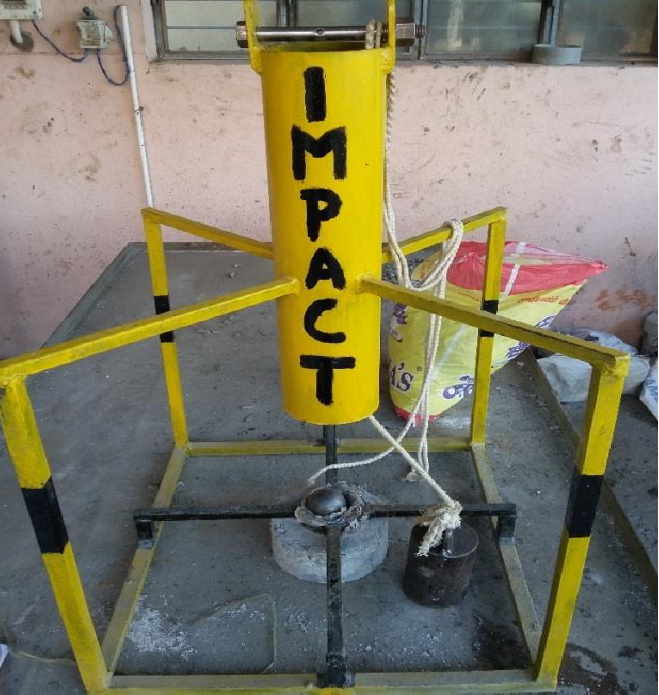
Figure 3. Impact testing machine.